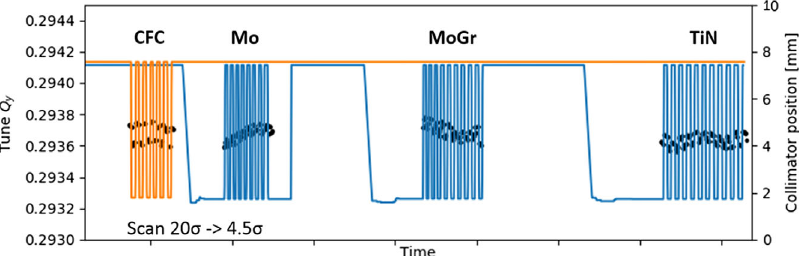
FIG. 4. The raw tune measurement data shows a clear reduction of the tune shift with the new materials with respect to the CFC. A significant tune drift during the measurement, not related to the collimator movement, can also be seen. The orange line depicts the position of the jaws (full gap) of the standard CFC secondary collimator, the blue line — the prototype collimator. Black dots show individual tune